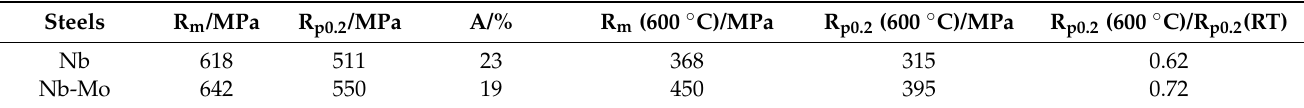
Table 2. Mechanical properties of two tested steels.